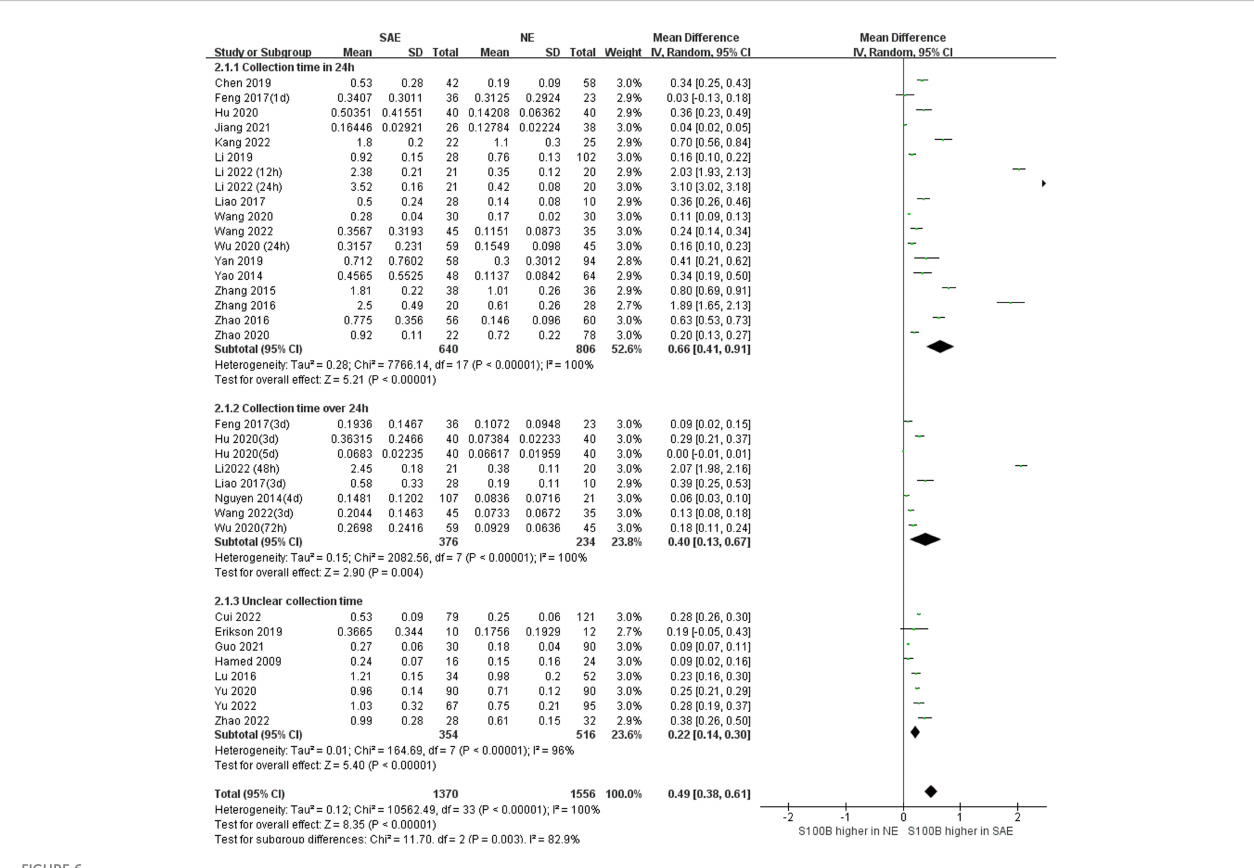
FIGURE 6 Meta-Analysis forest plot: association between serum S100B level and patients with SAE in different serum sample collection time after ICU